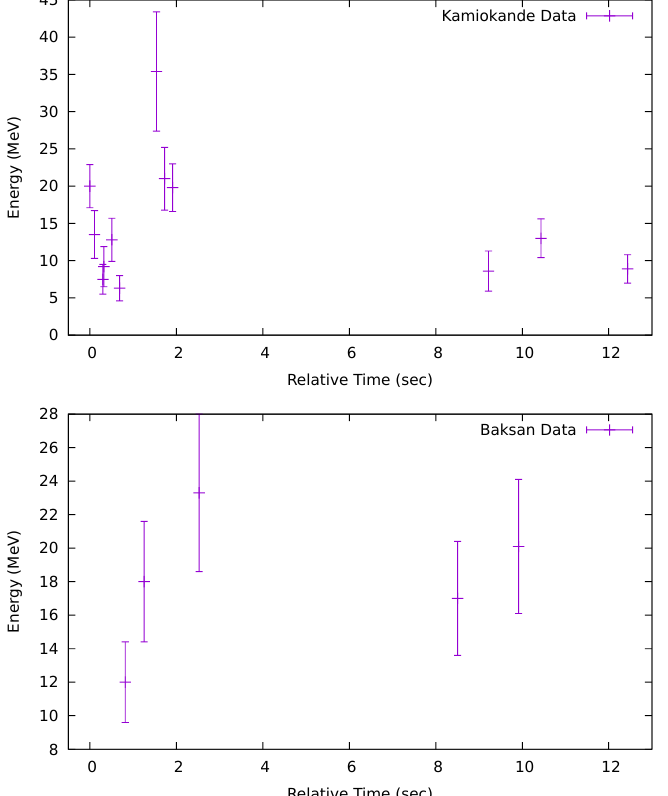
Figure 2. The Kamiokande neutrino events ( top ) and Baksan ( bottom ) from SN1987A plotted as event energy as a function of relative time. There is a notable gap in both data samples. The relative time between the plots is arbitrary. It is not the nominal time listed in Table 1.